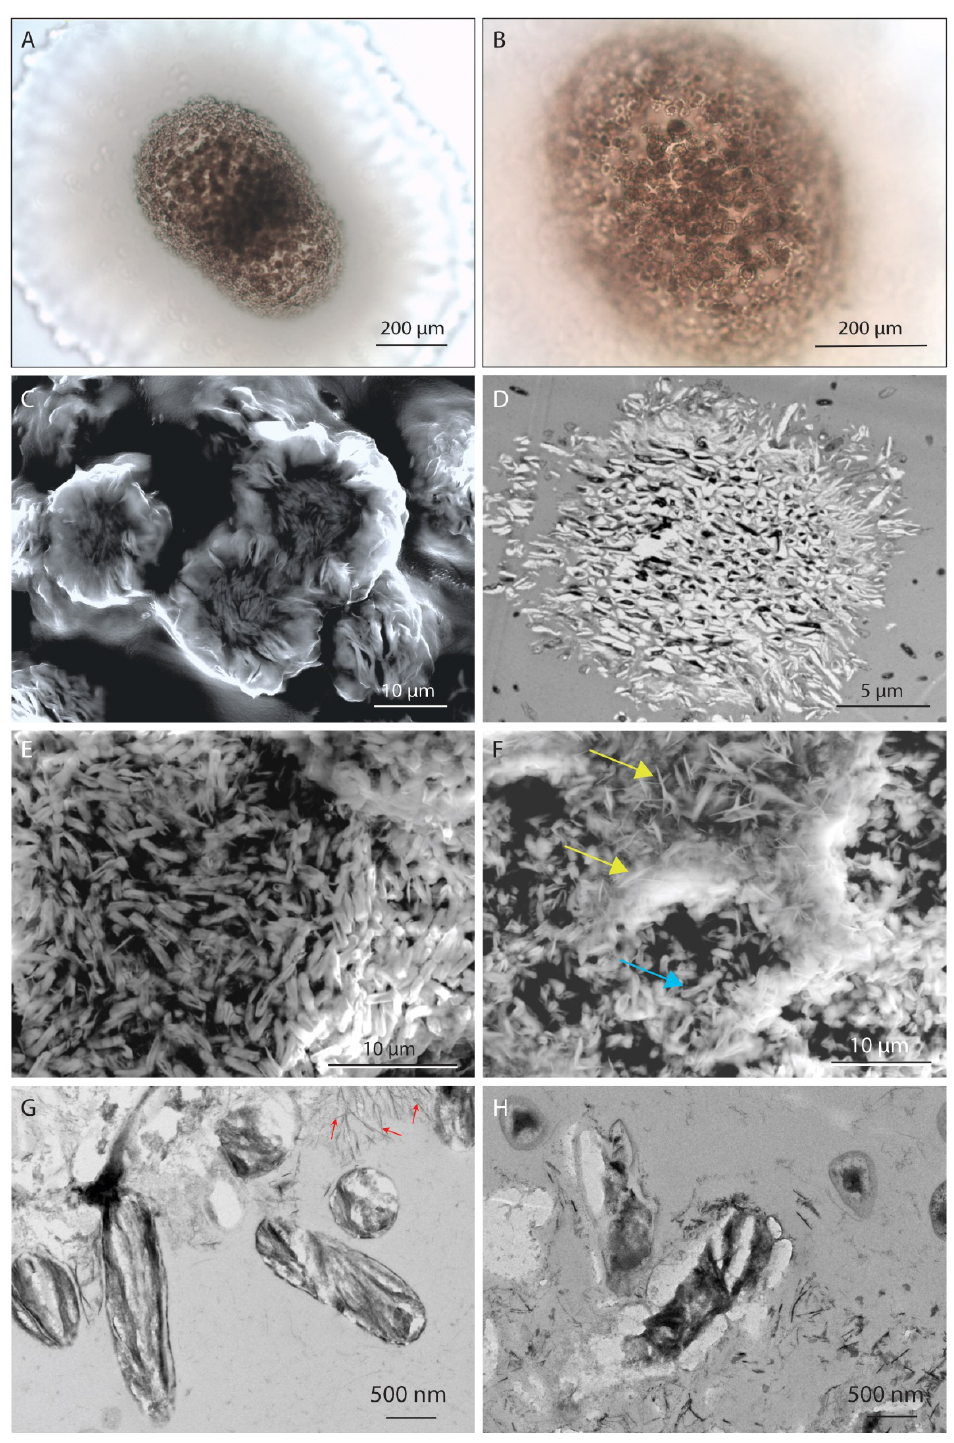
Figure 2. Micrographs of an isolated Mn(II) oxidizing bacterium, Hydrogenophaga sp., and associated Mn precipitates. ( A , B ) Light-microscopy images showing a colony with Mn precipitates located at the center, giving them a fried-egg appearance. ( C ) SEM image showing close-up of Mn precipitates in ( A , B ). ( D ) TEM image showing bacteria trapped in an aggregate of Mn oxide particles. ( E ) SEM image showing rod-like crystals of similar size and shape as the bacterial cells. ( F ) Growth of blade-shaped crystals (yellow arrows) forming a matrix that bind together the remains of mineralized bacterial cells (blue arrow). ( G ) TEM image of mineralized bacteria with preserved cell walls. Red arrows also showing Mn precipitates filling the space in between bacteria with branching blade-like precipitates. ( H ) Mineralized bacteria embedded in sheaths of Mn precipitates.